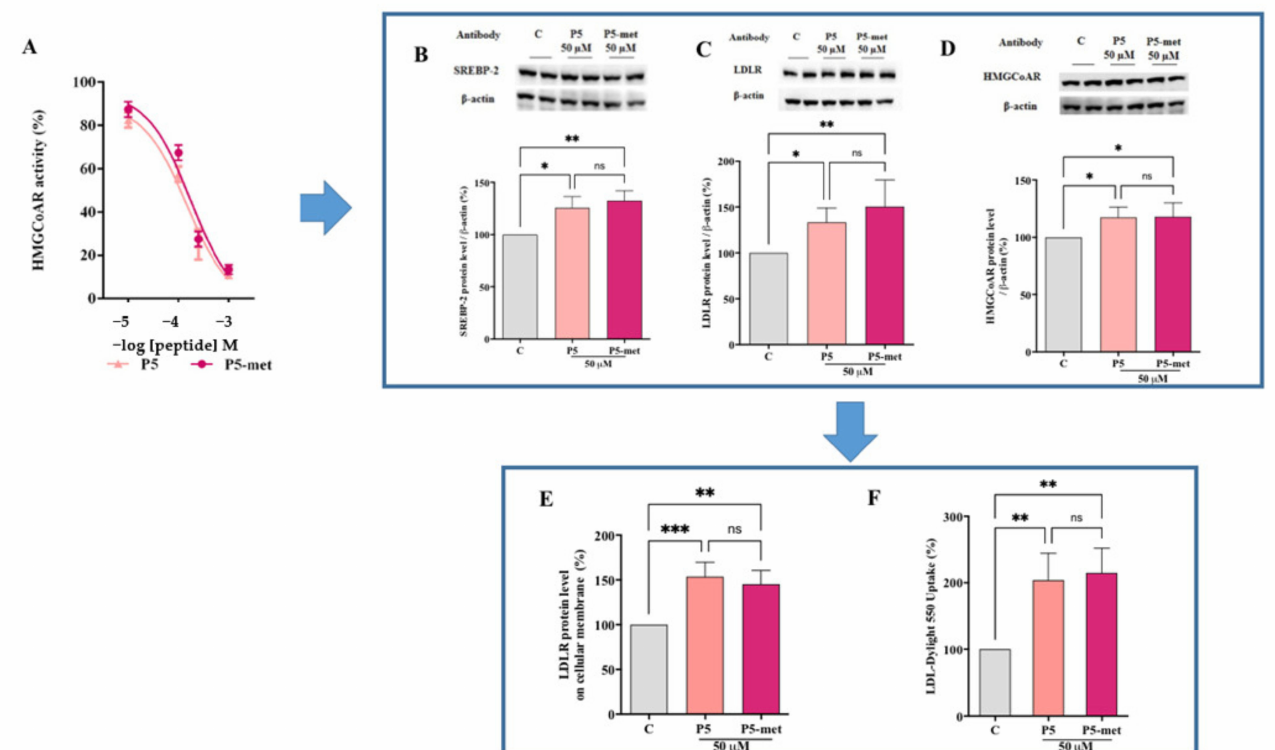
Figure 4. Modulation of low-density lipoprotein receptor (LDLR) pathway in HepG2 cells treated with P5 and P5-met. ( A ) In vitro inhibition of the HMGCoAR activity with IC 50 values equal to 147.2 and 175.3 µ M, respectively. ( B ) After the treatment of HepG2 cells with P5 and P5-met, the SREBP-2 protein level was increased, as well as ( C ) the LDLR and ( D ) the HMGCoAR protein levels, and ( E ) the LDLR localized on the surface of hepatic cell. ( F ) Enhancement of functional ability of hepatic cells to uptake LDL from the extracellular environment. Data points represent the averages ± SD of four independent experiments performed in duplicate. C vs. P5 and P5-met samples were analyzed by One-Way ANOVA followed by Dunnett’s test; (*) p <0.05; (**) p < 0.01 (***) p < 0.0001. C: control sample; ns: not